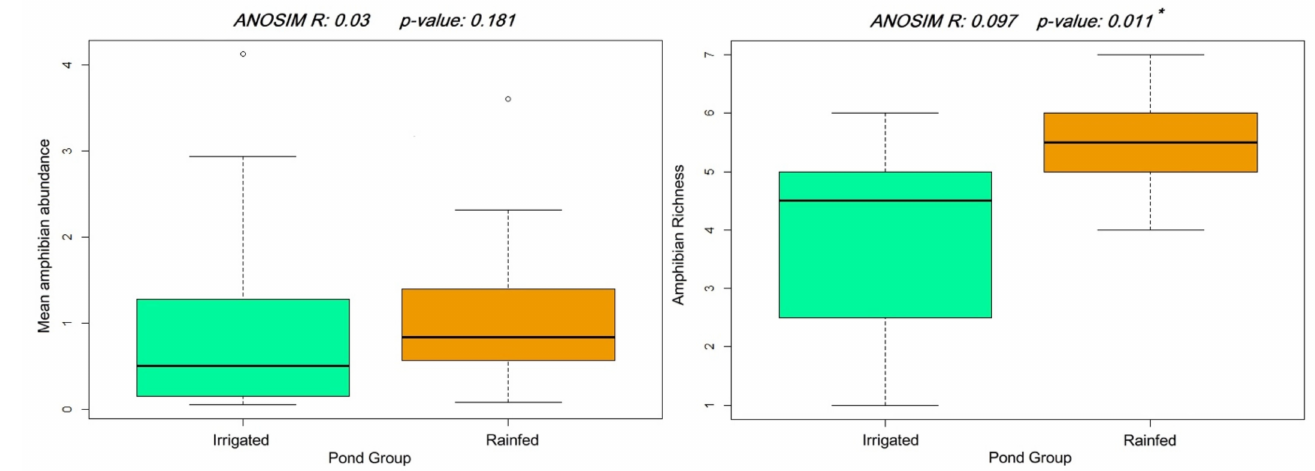
Figure 2. Comparison of mean amphibian abundance ( left ) and species richness ( right ) between irrigated and rainfed areas. * Significant under α = 0.05.